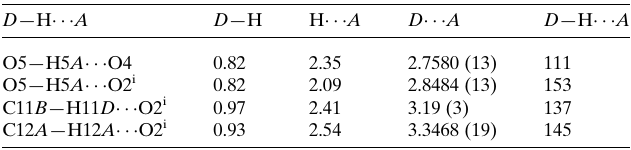
Table 1 Hydrogen-bond geometry (A˚ , (cid:4) ).